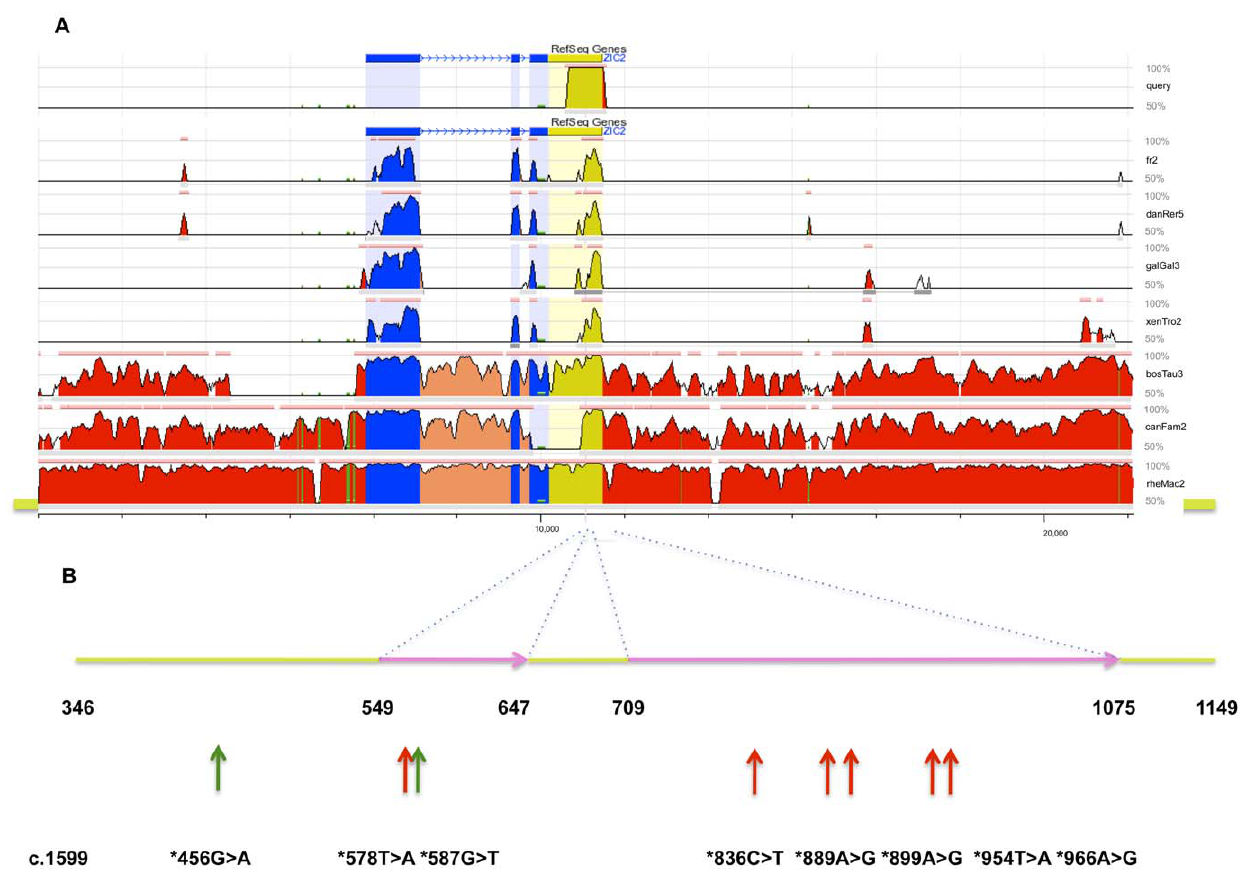
Figure 1. A Vista plot display of a multiple-species alignment of human ZIC2 . (A) ECRbase view of the vertebrate Zic2 regions (for these orthologs transcription from 5 9 to 3 9 is left to right) and where coding regions (blue), introns (orange), 3 9 non-coding transcribed regions (yellow) and intergenic segments (red) are displayed. Vista plot peaks reflect the extent of homology ( . 50–100%) compared to the query sequence (human ZIC2 3 9 UTR, 804 bp). (B) An enlargement of the two segments (pink: ECR # 1_99 bp and ECR # 2_367 bp) that retain conservation . 50% between human and zebrafish in the 804 bp screened region (yellow). The positions of the polymorphic variations (green arrows) and unique variations (red arrows) are numbered from the last base of the stop codon (c.1599) of the human ZIC2 reference sequence